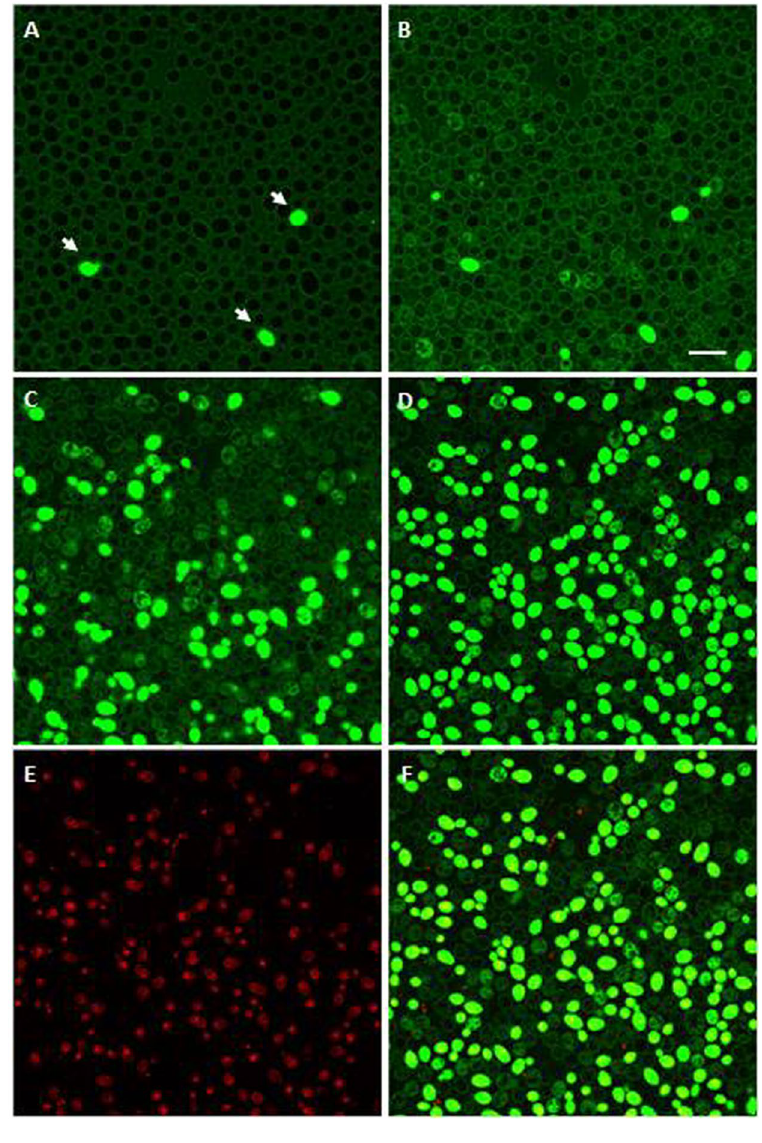
Figure 4. Internalisation of the L18R peptide into Candida albicans SC5314 cells. Confocal images of living yeast cells incubated in the presence of the fluorescein-labeled peptide for 5 min, 30 min, 50 min and 65 min are presented in panels A to D. The same field is shown. Labeled L18R bound to the surface of all yeast cells in a few minutes, then was progressively internalised by yeast cells. After 65 min, fluorescence was diffused in yeast cells that were no longer viable as assessed by propidium iodide internalisation (panel E). Panel F: merge of panels C and E. Non-viable yeast cells in the inoculum passively internalised L18R peptide (panel A, arrows). Bar = 10 μ